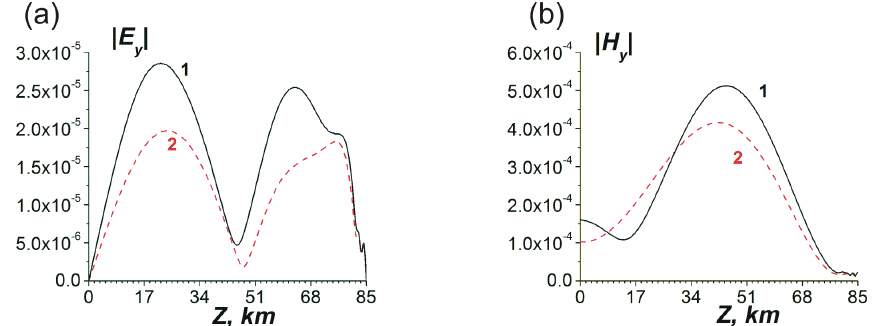
Figure 13. Altitude distributions of the normalized tangential ( y ) electric (a) and magnetic (b) VLF beam field components in the central plane of the transverse beam distribution ( y = 0) at the distance of x = 1000km from the input of the system. Line 1 in (a, b) corresponds to the presence of the mesospheric electric current source only with a relatively small value of N e and a large ν e . Line 2 corresponds to the presence of both mesospheric and near-ground seismogenic electric current sources with a relatively large value of N e and small ν e . Lines 1 and 2 in (a) and (b) correspond qualitatively to the lines 1 and 3, respectively, in Fig. 12b, with ω = 1 . 5 × 10 5 s − 1 and θ = 45 ◦